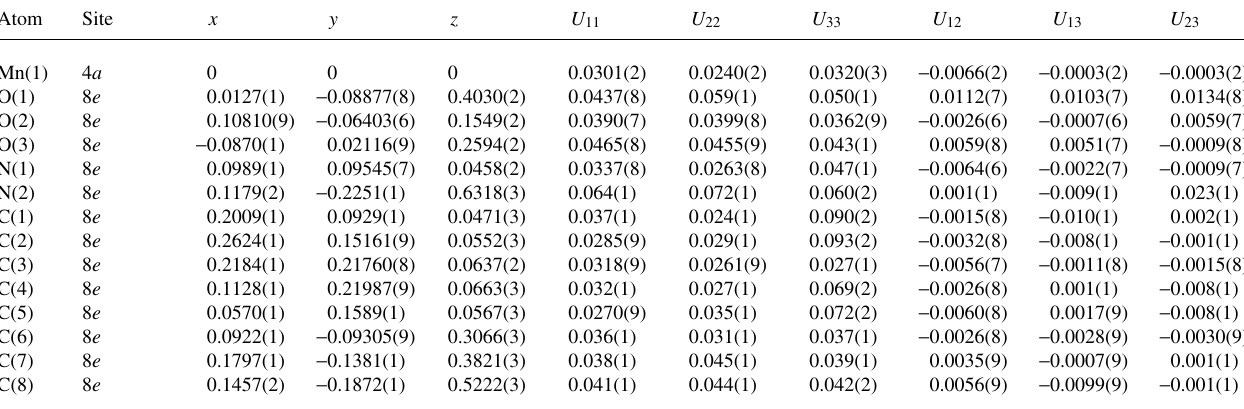
Table 3. Atomic coordinates and displacement parameters (in Å 2 ) .